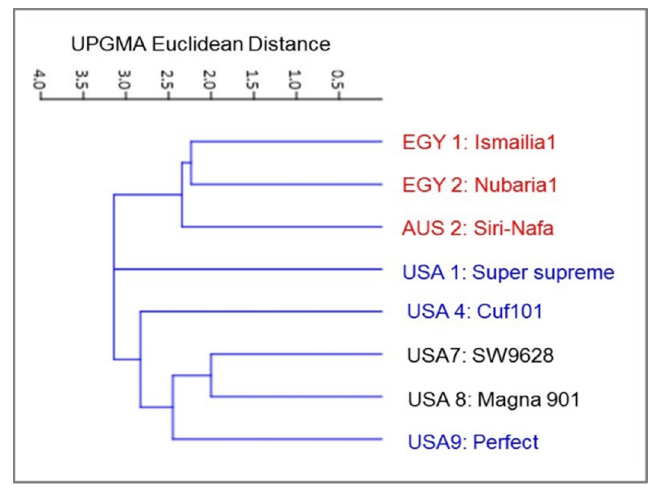
Figure 7. Cluster tree illustrating the genetic distance, based the analysis of 16 morpho-agronomic traits for eight M. sativa cultivars using the Euclidean distance and the UPGMA algorithm in the PAST software.